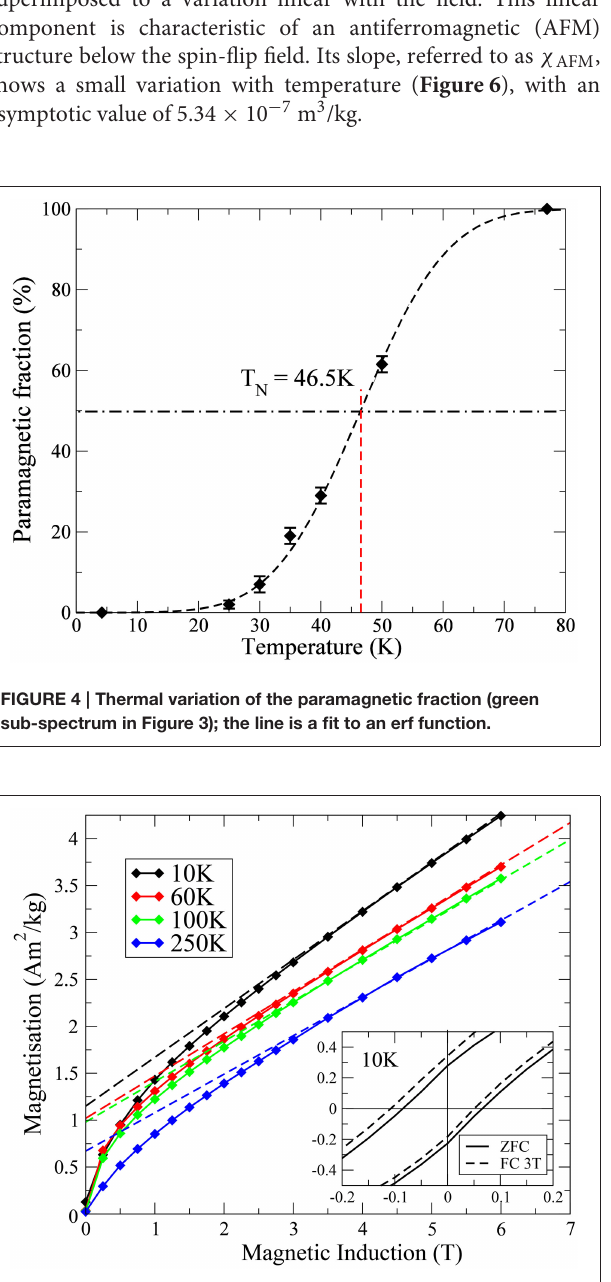
FIGURE 5 | Isothermal magnetization curves in lepidocrocite at selected temperatures; the dashed lines are fits of the magnetization curves to a linear law: M = M 0 + χ AFM µ 0 H . Inset: close-up of the hysteresis loop at 10 K